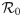
The Partial Rank Correlation Coefficients (PRCC) of the basic reproduction number, R0, (panel (a)) and total GBS cases (panel (b)) with respect to model parameters.The Sh(0) in this figure denotes the initial susceptible ratio, i.e, Sh(0)/Nh. The black circle is the estimated correlation, and the bar represents 95% CI. The ranges of parameters are in Table 1.